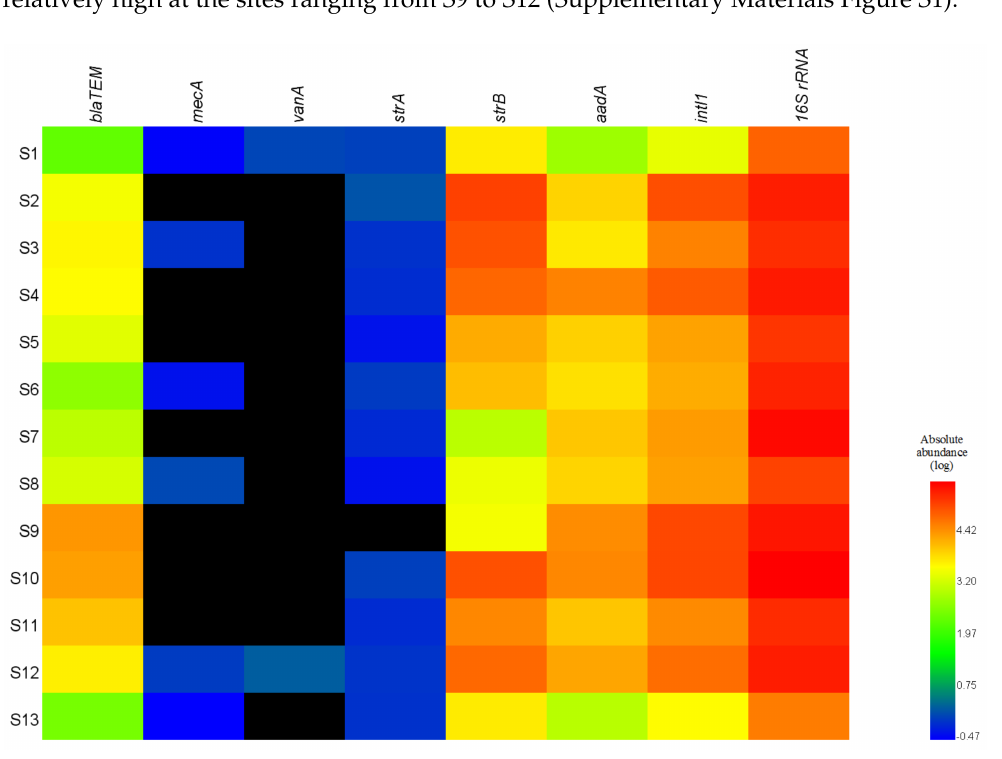
Figure 2. Heatmap showing the absolute abundances of antibiotic resistance genes (ARGs), intI1 , and 16S rRNA genes in water samples collected from the Weihe River. Black denotes the absence of